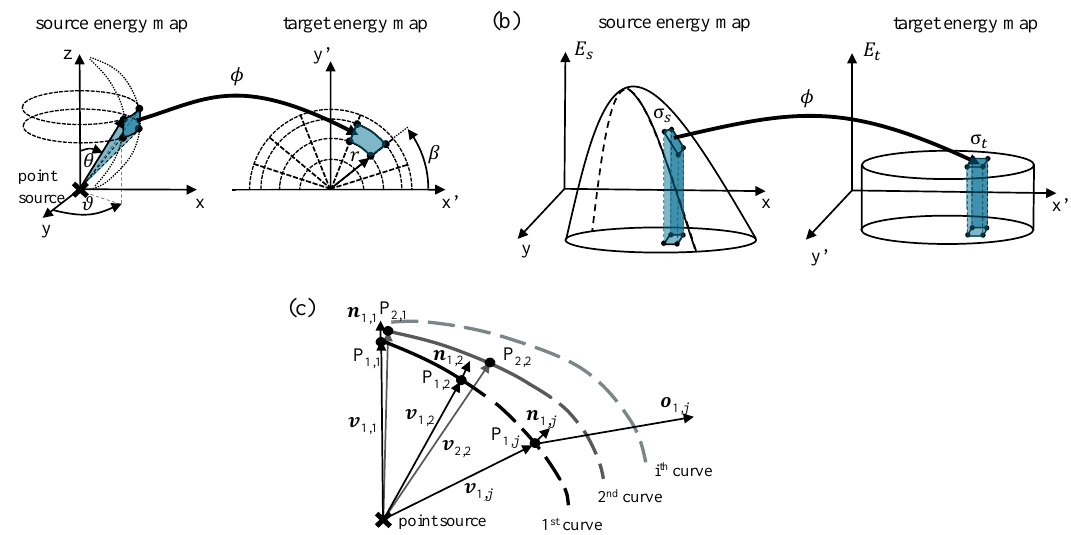
Figure 5. Energy and ray mapping. ( a ) Equi-flux grids at the source and target. Adapted from Wang et al. [39]. ( b ) Mapping from non equi-flux source to anticipated target irradiance. ( c )